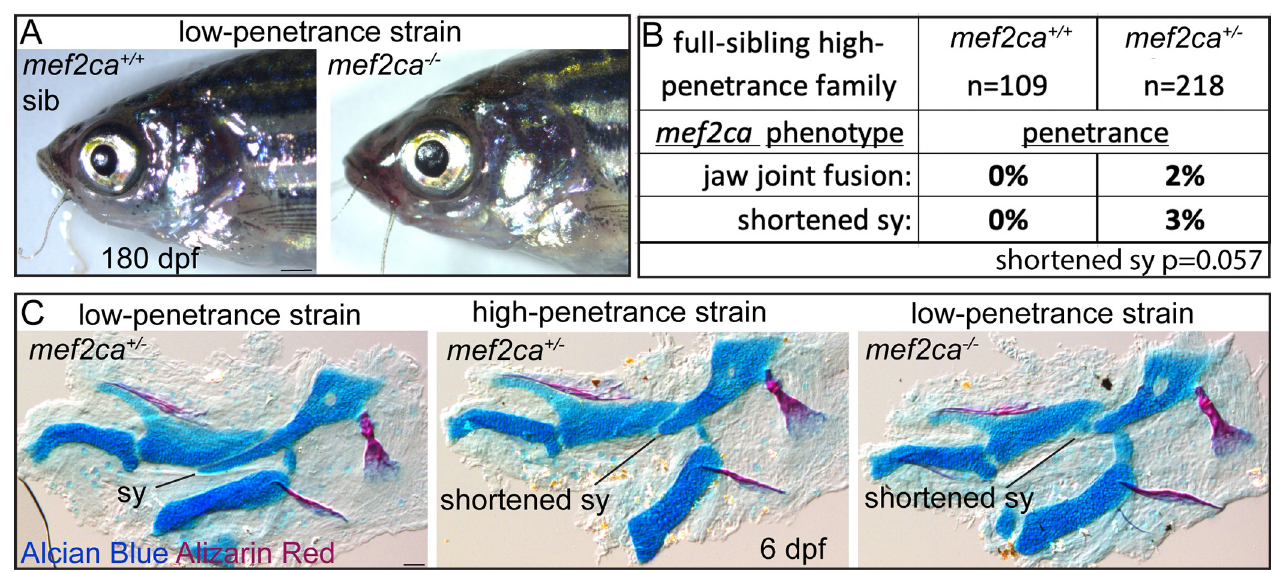
Fig 4. Selective breeding just for ectopic bone penetrance modifies the behavior of the mef2ca b1086 mutant allele. (A) Low-penetrance mef2ca heterozygous adults were intercrossed and offspring were grown to adulthood. Fin amputation and genotyping identified mef2ca homozygous adults, which were imaged alongside wild-type siblings. Scale bar: 1mm. (B) 6 dpf full-sibling individuals from a single high-penetrance family were stained with Alizarin Red (bone) and Alcian Blue (cartilage), then genotyped and mef2ca heterozygotes and homozygous wild types were scored for presence of all mef2ca -associated phenotypes. (C) 6 dpf Alizarin Red and Alcian Blue stained skeletons were dissected and flat mounted, lateral view. In these individuals, a shortened symplectic (sy) cartilage phenotype is evident in mef2ca heterozygotes from the high-penetrance strain and mef2ca homozygous mutants from the low-penetrance strain. Scale bar: 50 μ